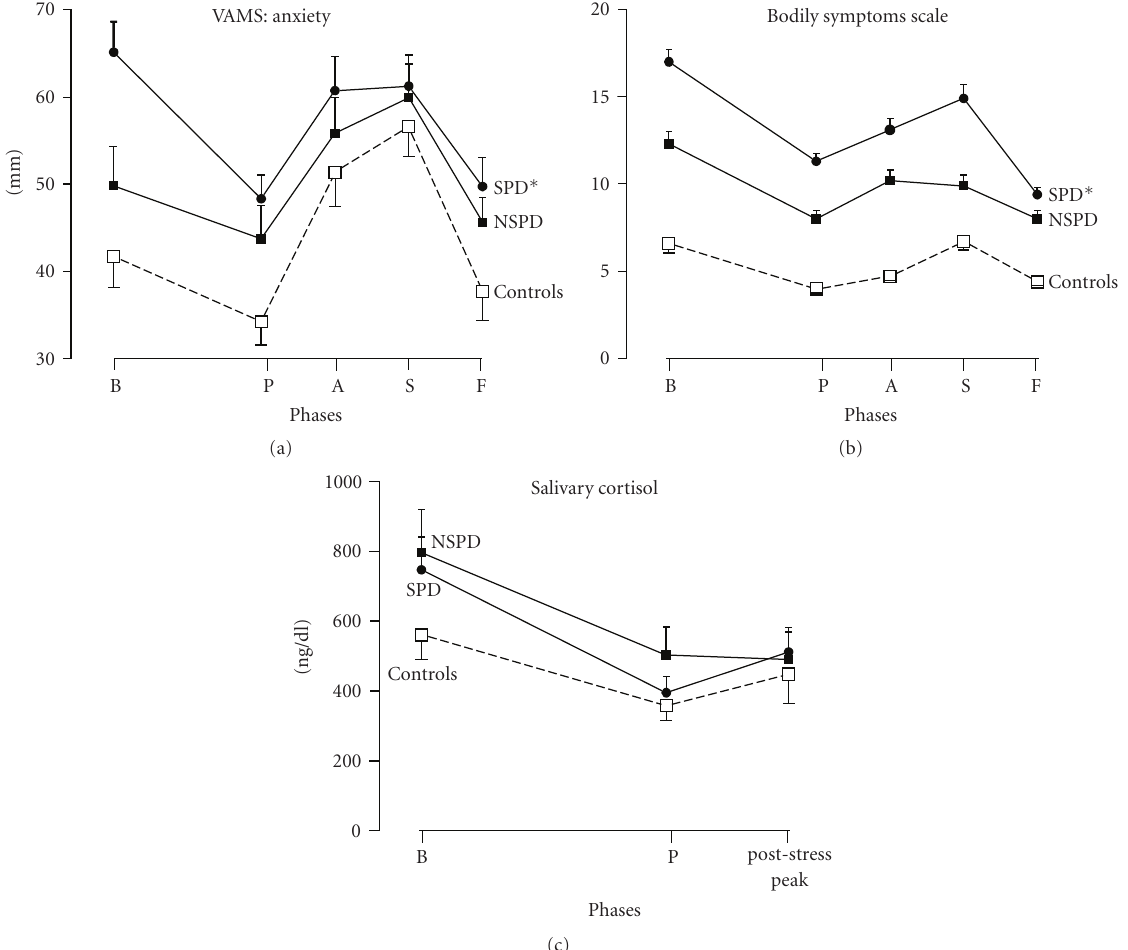
Figure 2: Changes in anxiety (VAMS, upper panel), bodily symptoms (BSS, mild panel), and salivary cortisol levels (lower panel) induced by simulated public speaking (SPS) in symptomatic panic patients (SPD), nonsymptomatic patients (NSPD), and healthy controls. The phases of the experimental session are beginning (B), pretest (P), anxiety during speech preparation (A), performance anxiety during the speech (S), and final (F). Points in the curves indicate mean values and vertical bars the S.E.M. Figure modified from Garcia-Leal et al. [43] and Parente et al. [44]. ∗ = significant di ff erence ( P < . 05) from